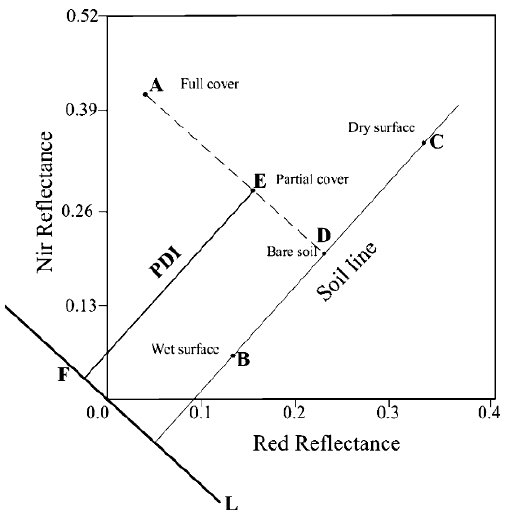
Fig. 3 Sketch map of PDI (Gulam et al,